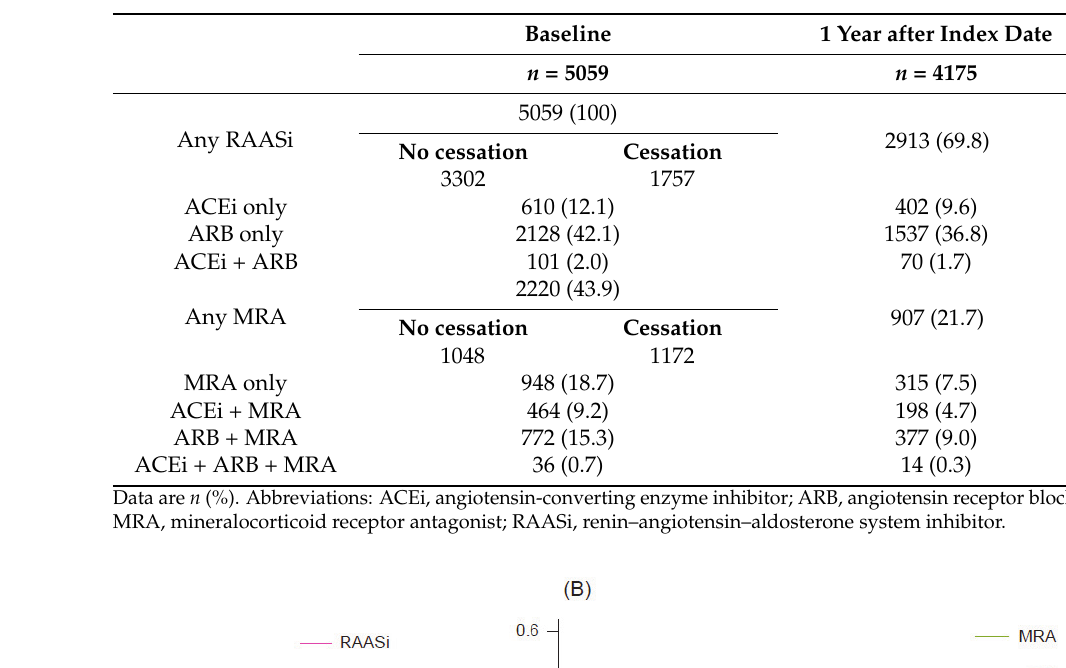
Table 2. RAASi treatment patterns at baseline.